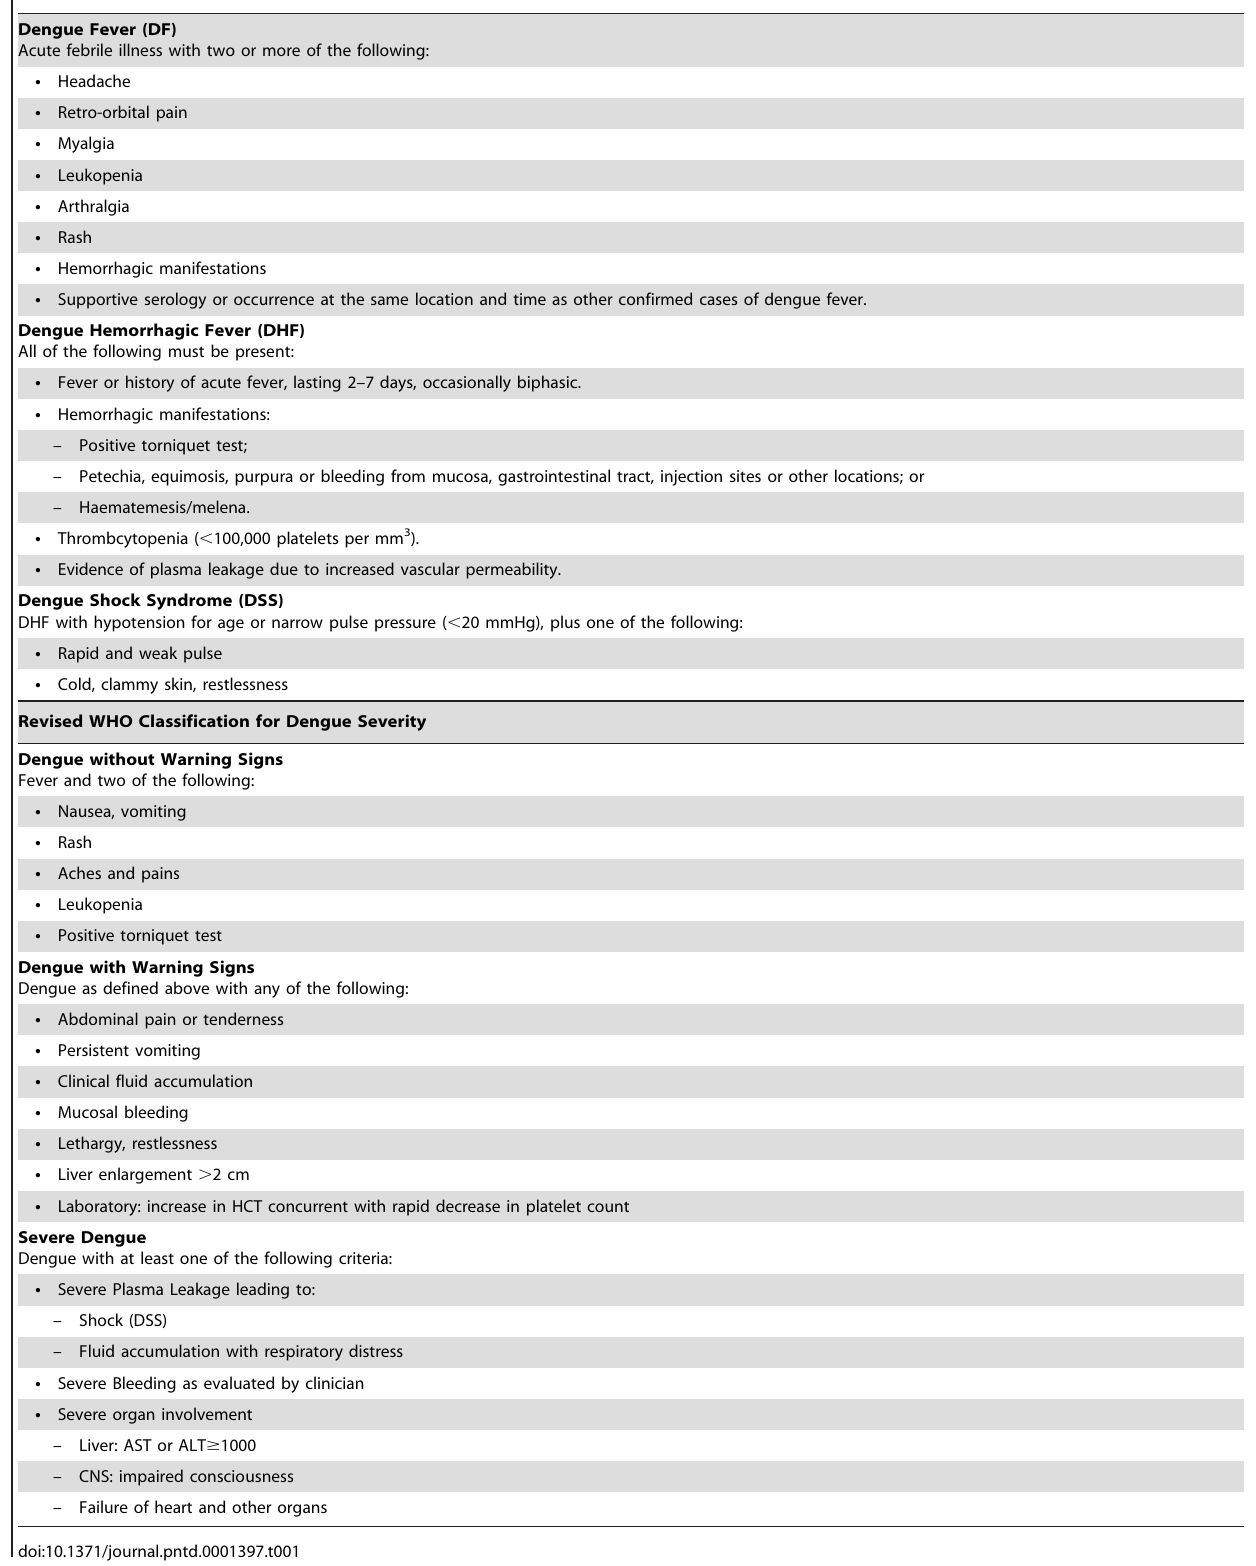
Previous WHO Classification for Dengue